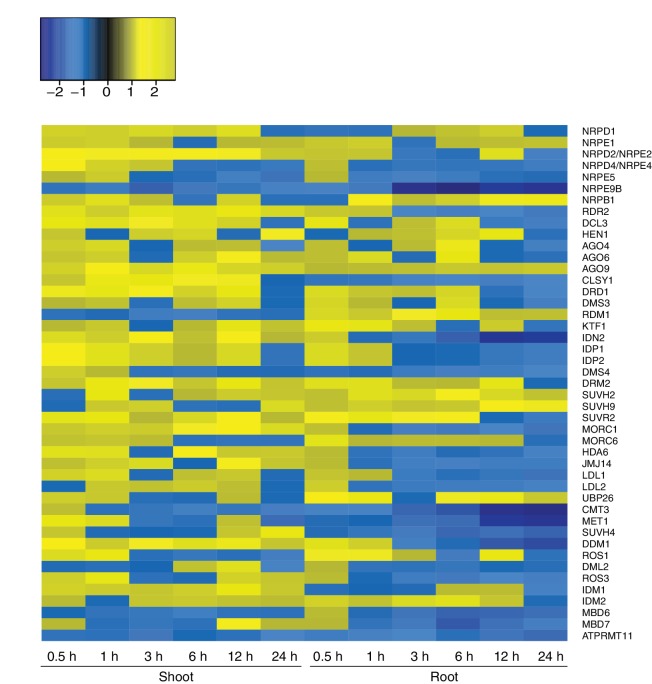
Expression of RdDM and demethylation pathway genes in response to hyperosmotic stress.Heatmap showing expression of genes from RdDM and demethylation pathways after exposure to hyperosmotic stress (0.5 to 24 hr) in shoots and roots (Zeller et al., 2009). Gene names are listed on the right. Blue indicates down-regulation and yellow indicates up-regulation by hyperosmotic stress.